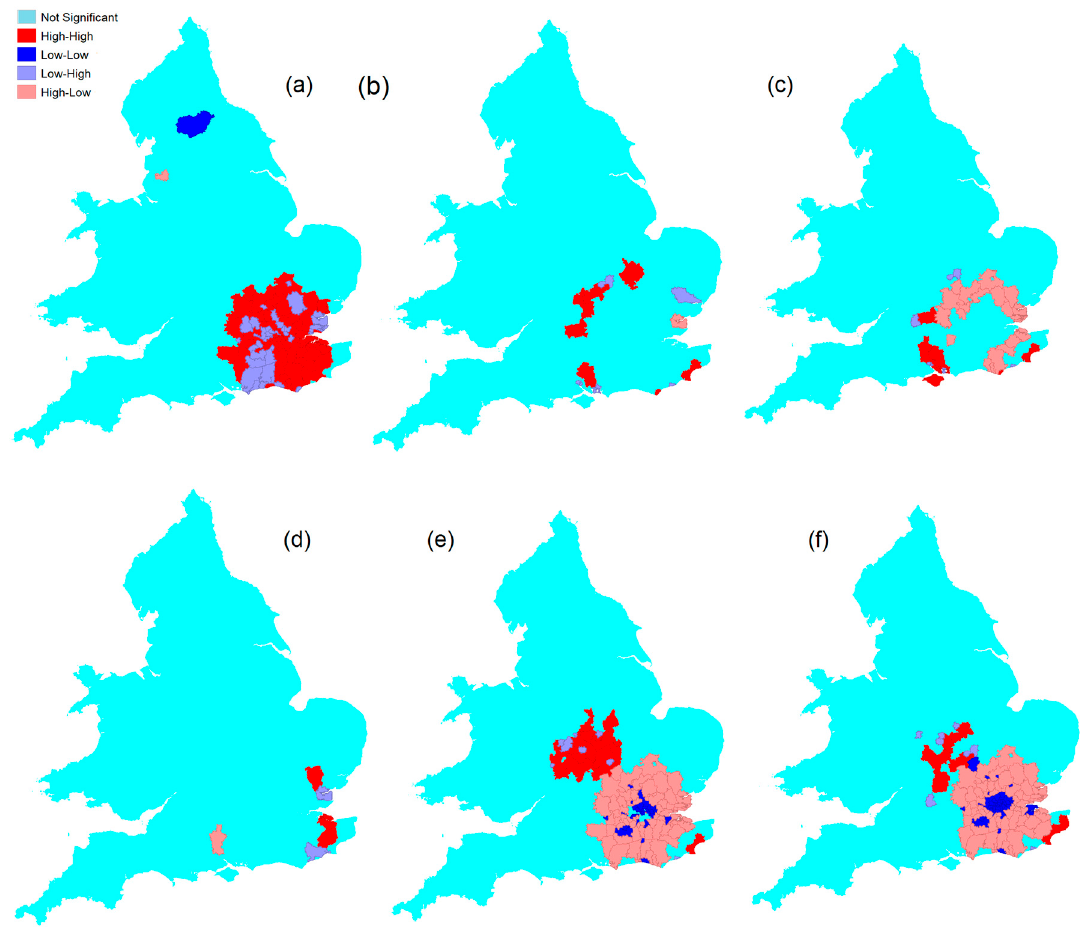
Figure 4. LISA Maps Migration (25–29; 30–34 and 35–39 years old). ( a ) Range of 25–29-year-olds in 2012; ( b ) 30–34 year olds in 2012; ( c ) 35–39 year olds in 2012; ( d ) 25–29 year olds in 2018; ( e ) 30–34 year olds in 2018; ( f ) 35–39 year olds in 2018.